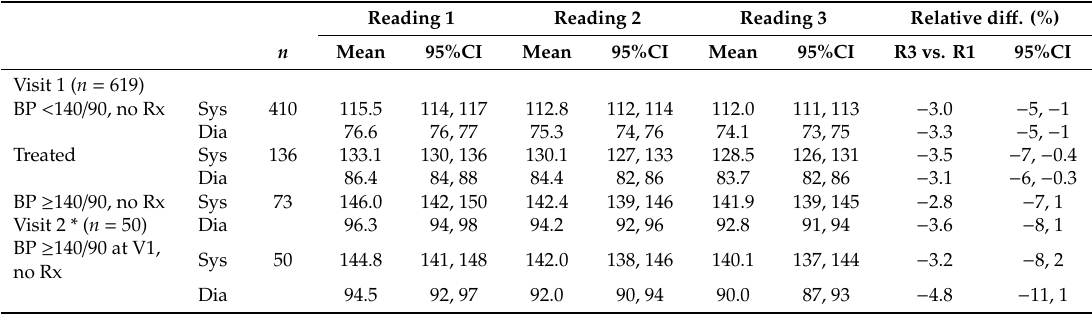
Table 2. Mean systolic and diastolic blood pressure on three successive blood pressure readings according to hypertension status and di ff erent visits in the community-based screening programme. Reading 1 Reading 2 Reading 3 Relative di ff . (%) n Mean 95%CI Mean 95%CI Mean 95%CI R3 vs. R1